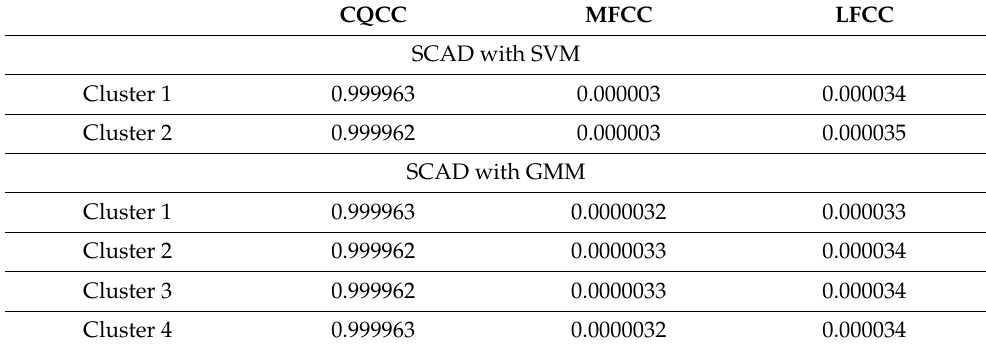
Table 8. Feature weights estimated for each cluster on the ASVspoof 2017 version 2.0 benchmark dataset.